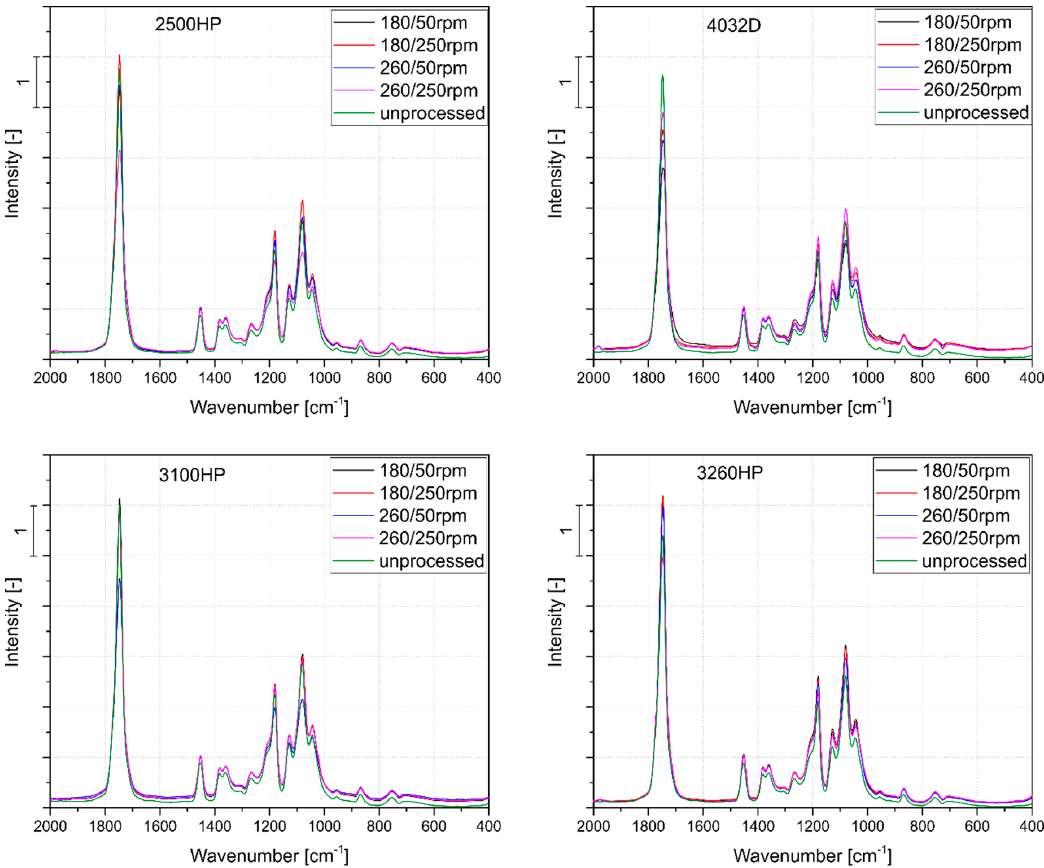
Figure 2. Fourier-transform infrared spectroscopy (FT-IR) spectra of PLA grades processed in an extreme range of processing parameters, as well as the compression-molded unprocessed materials.